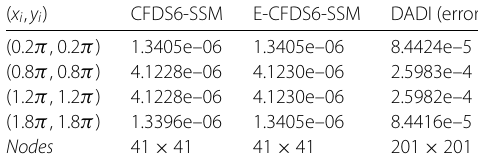
Table 3 The error of two different schemes for SP 2 at t = 2 ( x i , y i ) CFDS6-SSM E-CFDS6-SSM DADI (error) (0.2 π , 0.2 π )